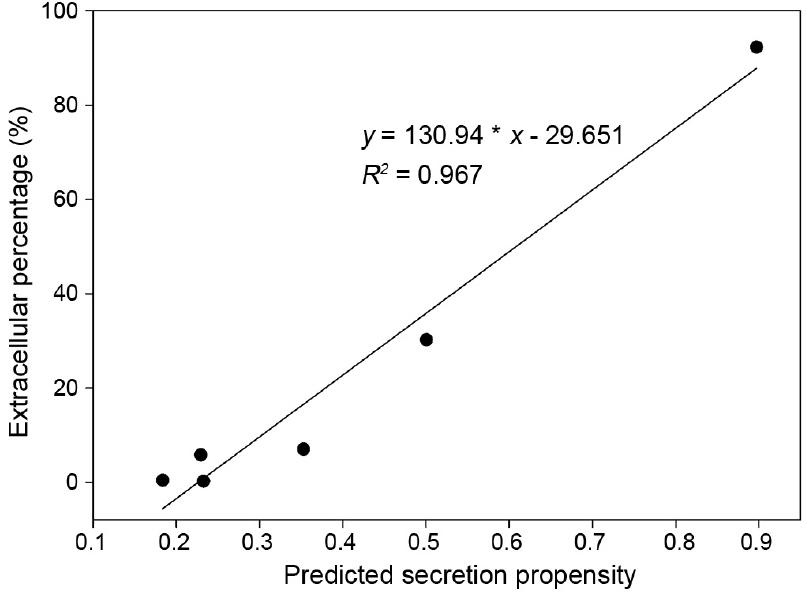
Figure 4. Correlation between the predicted secretion propensity, as determined by Presep, and the extracellular percentage (%) determined using the experimental